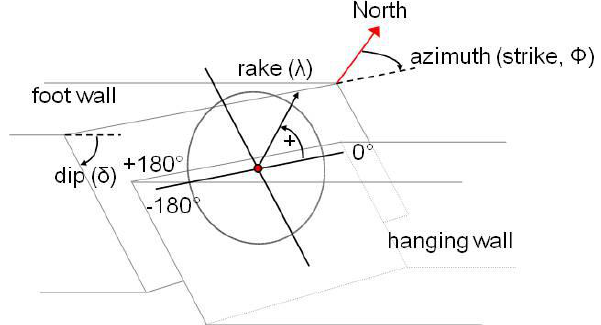
Fig. 1. Visualization of fault and focal mechanism (Elnashai et al., 2008).